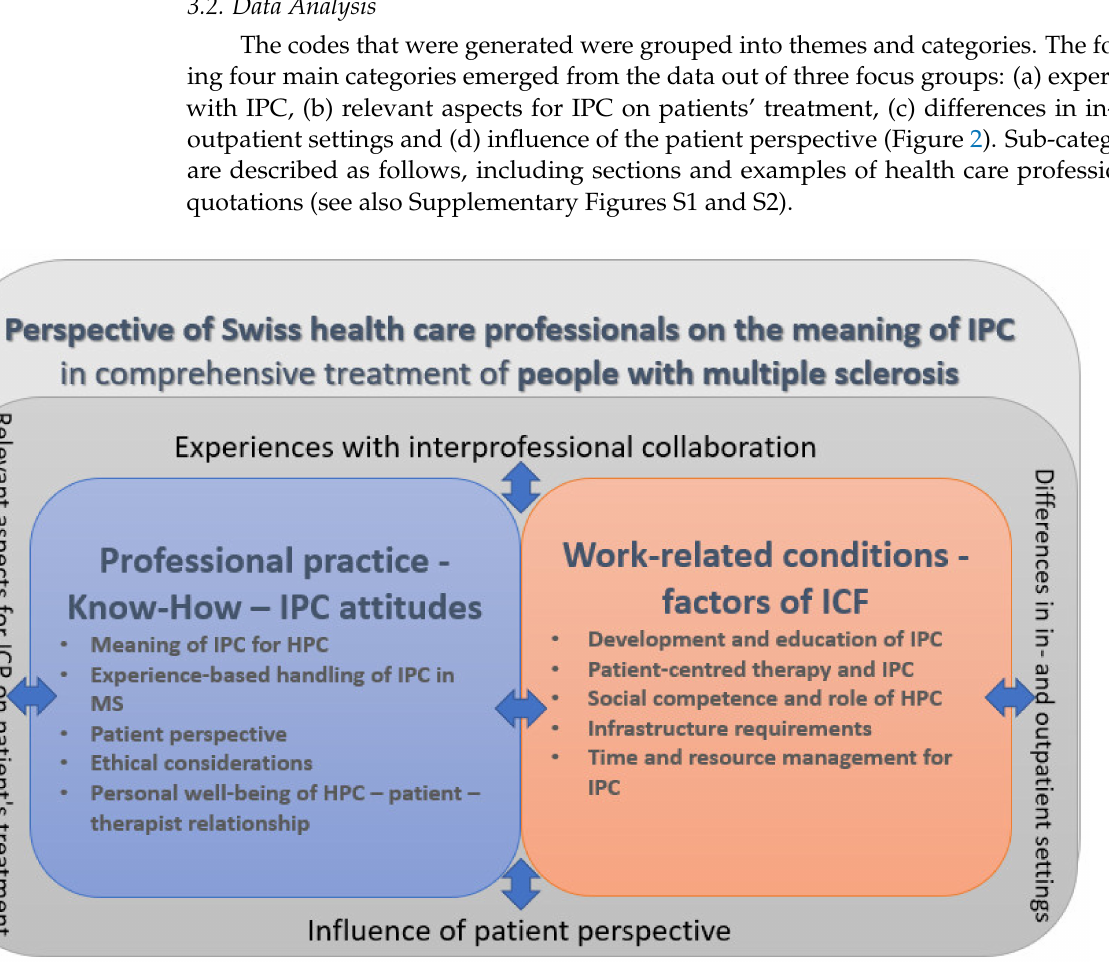
Figure 2. Overview of results from a health professional perspective (health care professionals =